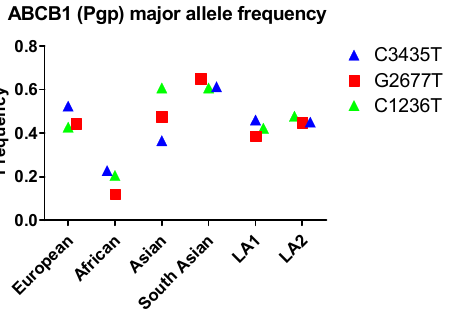
Figure 1. The allele frequency of ABCB1 in different populations. Asian: All Asian individuals excluding South Asians; LA1, Latin American individuals with Afro-Caribbean ancestry; LA2: Latin American individuals with mostly European and Native American Ancestry. Data were extracted from NCBI (National Center for Biotechnology Information) ALFA project (version: 20200227123210, www.ncbi.nlm.nih.gov/snp/docs/gsr/alfa/ [17]). At a functional level, it is still controversial whether the C3435T allele causes a de- crease of Pgp function. Some studies have reported that C3435T deceased Pgp expression in the liver and other tissues, probably due to mRNA stability issues [18,19], while others have failed to confirm the reduction of protein expression [20]. With respect to function, C3435T led to diminished efflux in most in vitro studies [21]. For example, P-gp activity of the efflux of Rh123, a probe of Pgp, was significantly lower in C3435T transfected BLL cells when compared to wild type (3435G) [22]. In in vivo studies, some showed that C3435T decreased drug absorption in the intestine and affected plasma drug exposure. Examples include decreased phenytoin absorption in Indian populations [23], and de- creased 3’-p-hydroxypaclitaxel plasma exposure (i.e., Area Under the Curve, AUC) in Japanese ovarian cancer patients with MDR1 C3435T alleles when compared to those of wildtype [24]. However, other studies showed that MDR1 C3435T alleles did not affect the PK profile of certain drugs. For example, it was reported that the PK profiles of fluvastatin, pravastatin, lovastatin, and rosuvastatin were not changed significantly in MDR1 C3435T carriers [25]. These discrepancies are probably caused by variations in drugs used in these different studies, some of which undergo multiple absorption/metabolism pathways. Even though absorption is altered, plasma drug exposure may not be influenced significantly. In addition to efflux function, SNP C3435T can also bring about changes in drug and inhibitor interaction and substrate specificity, probably because this SNP affects the timing of translational folding and insertion of Pgp protein into the membrane [26]. It is intrigu- ing that a synonymous polymorphism like C3435T is able to cause phenotypic